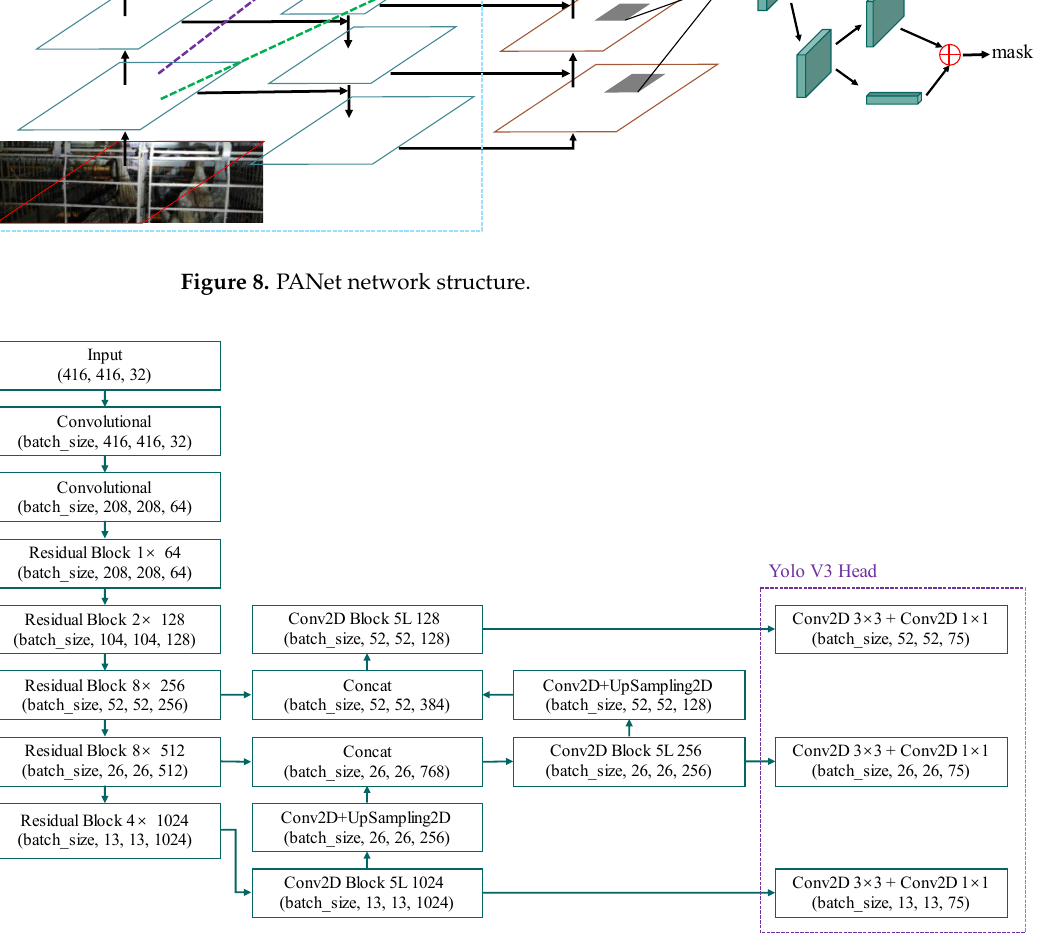
Figure 8. PANet network structure.